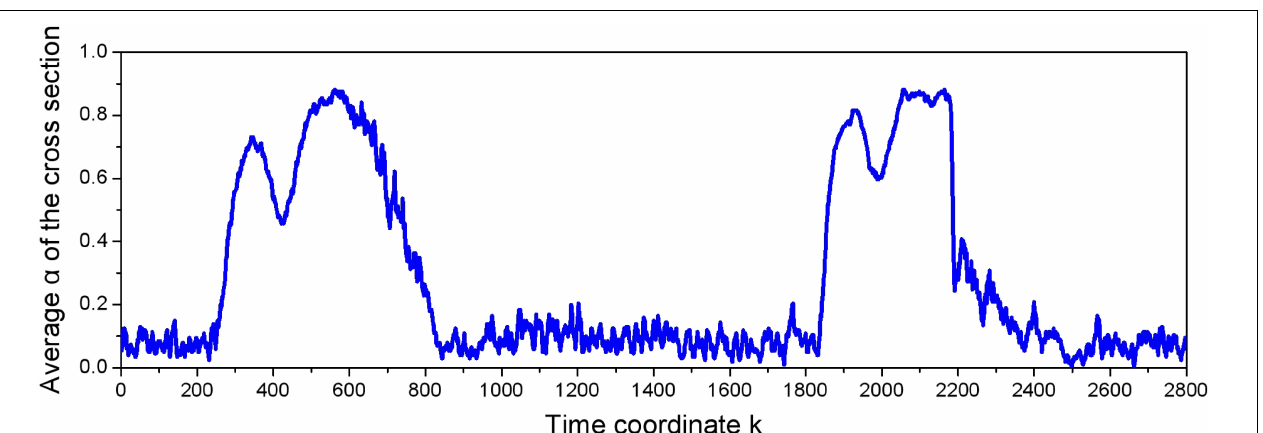
FIGURE 8 | The instantaneous void fraction of the cross section in test E5.